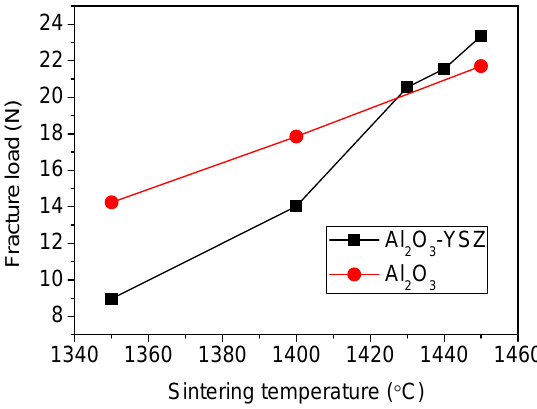
Figure 3. Three point bending fracture load of the Al 2 O 3 ‐ YSZ and pure alumina membranes [8].